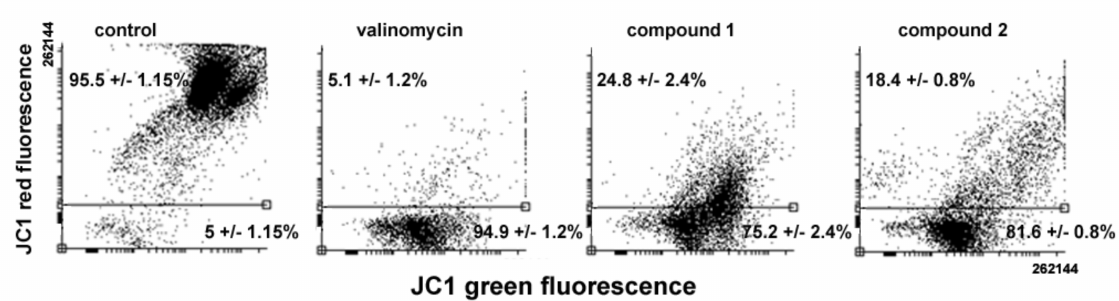
Figure 7. Representative flow cytometric analysis of MMP in MDA-MB-231 cells cultured in control conditions, or exposed to either valinomycin (as a positive control), 1, or 2 for 24 h. The percentages indicated in the bottom quadrants in each frame quantitate the amount of low red-emitting cells that underwent dissipation of MMP. The results are expressed as the mean ± SEM of triplicate